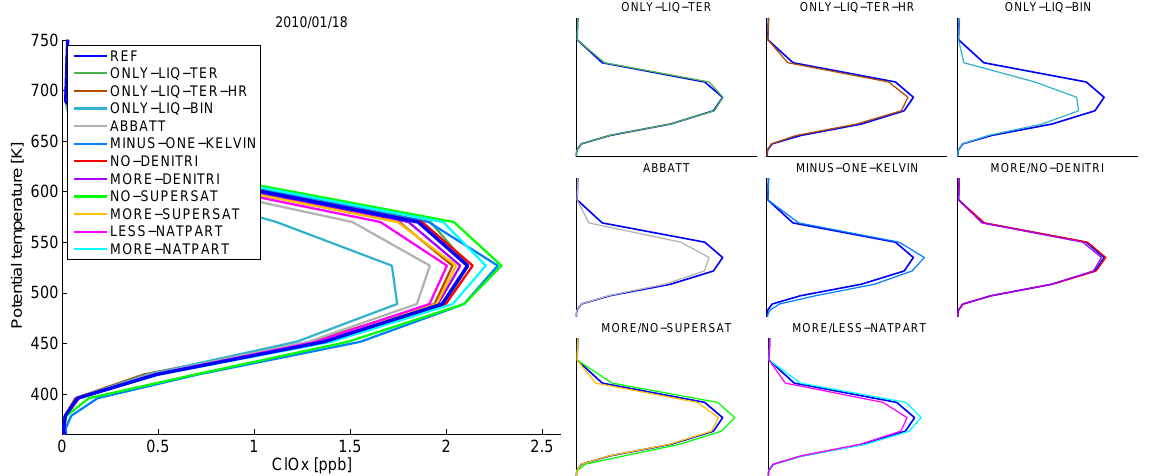
Fig. 4. Vortex-averaged ClO x for 18 January 2010 as a function of potential temperature for all sensitivity runs and the reference run. The different sensitivity runs are represented by different colours. Vortex average as in Fig. 1. The small plots on the right show only one or two sensitivity runs and the reference run at the same time for clarity.